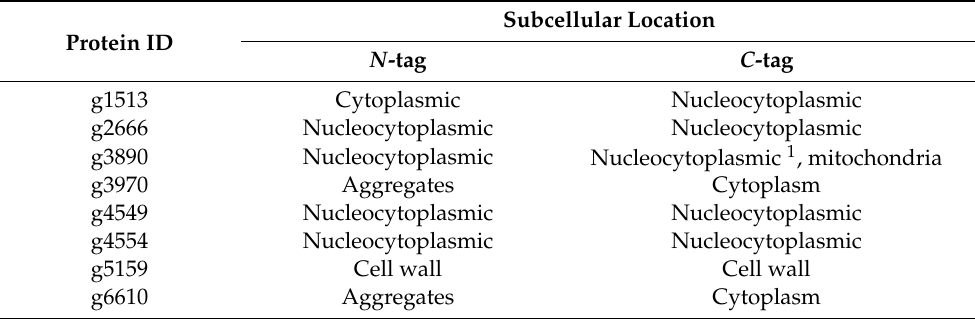
Table 3. Summary of the CE fusions presenting subcellular localization in N. benthamiana leaves.